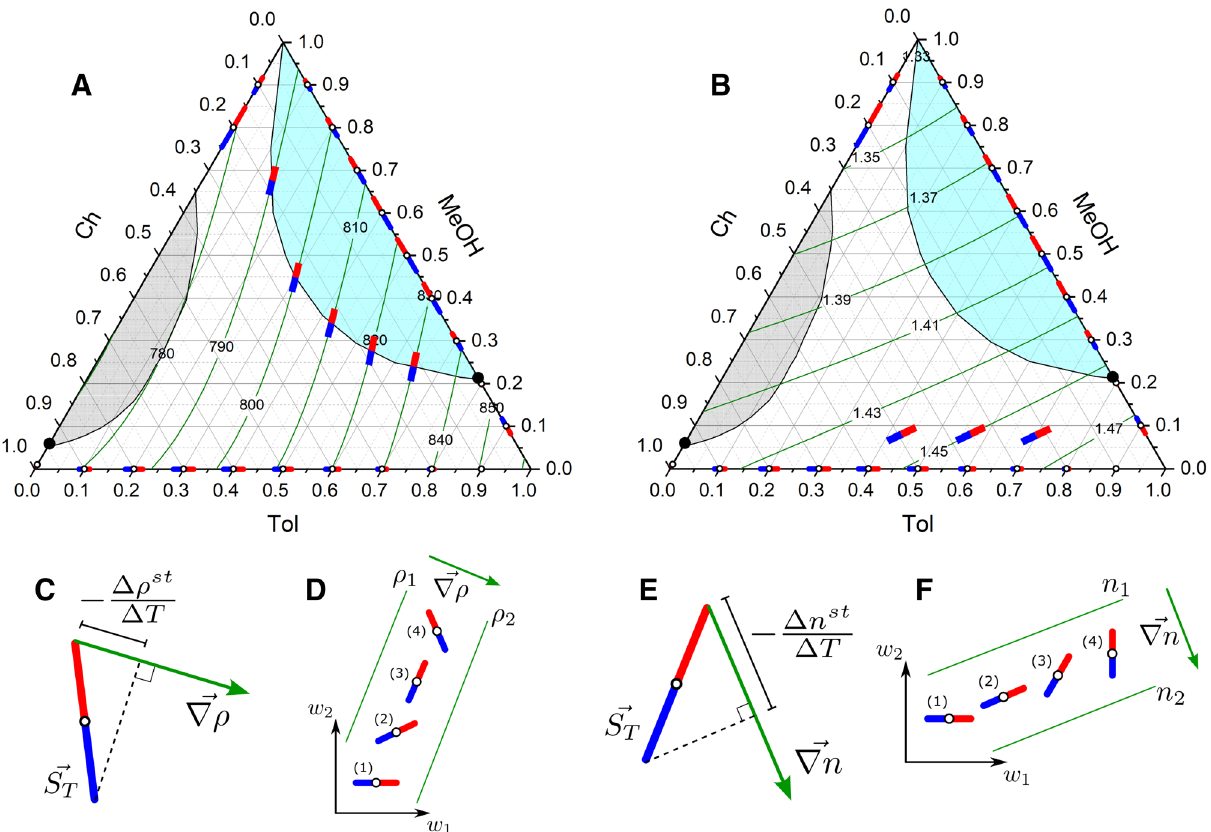
Figure 8. Binding the Soret vector with the density ( A ) and refractive index ( B ) maps in the Tol–MeOH–Ch ternary mixture. The green lines illustrate the isoline of either ρ ( A ) or n ( B ). The demixing zone is shaded in gray and stability region is shaded in blue. The Soret vectors, parallel to the density isolines near the stability boundary in ( A ), illustrate the situation when separation occurs, but the density does not change over the cell (isodense separation). The Soret vectors inside ( B ) illustrate the situation when separation occurs, but the refractive index does not change across the cell. ( C , E ) Illustrate graphically the projection of the Soret vector onto the gradient of density ( C ) or refractive index ( E ). Sketch of the Soret vector rotation in the space between two binary subsystems, which, in turn, changes its position relative to the density isoline ( D ) or refractive index ( F ) (vectors are not in